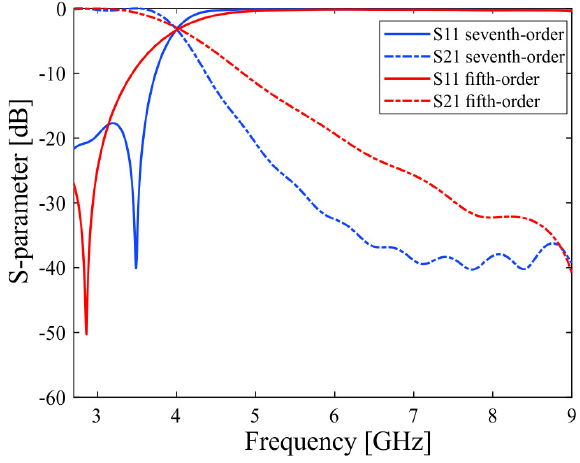
Figure 5. S-parameters of simulated fifth- and seventh-order Chebyshev low-pass filters.